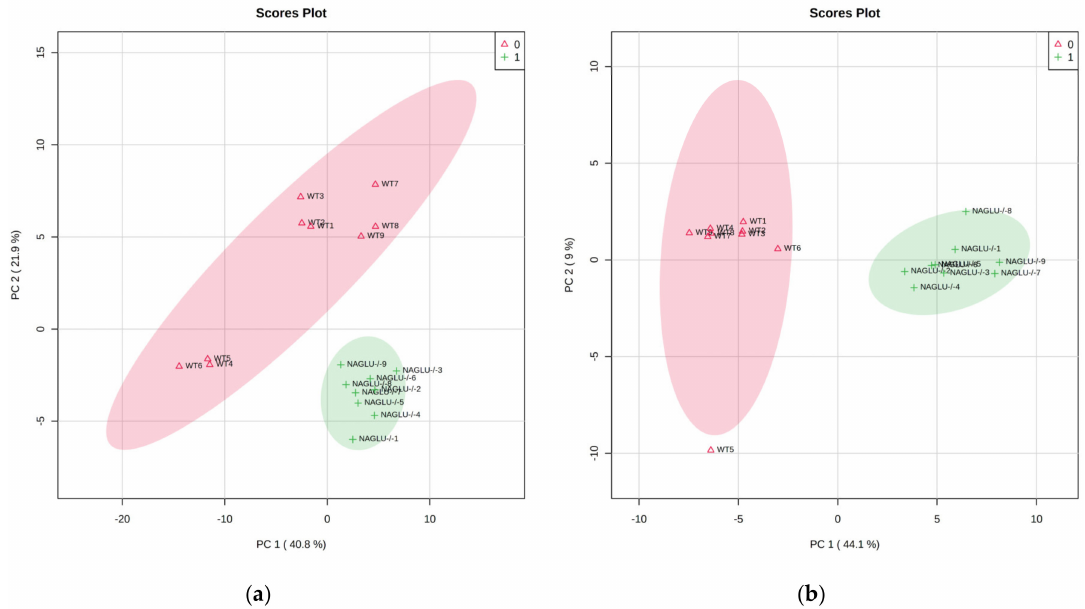
Figure 2. A principal component analysis (PCA) was performed using 48 metabolites from the heart ( a ) and liver ( b ) tissues. In NAGLU − / − heart, the first two principal components (PCs) explained 62.7% of the total variance (PC1 40.8%, PC2 21.9%). In NAGLU − / − liver, the first two PCs explained 53.1% of the total variance (PC1 44.1%, PC2